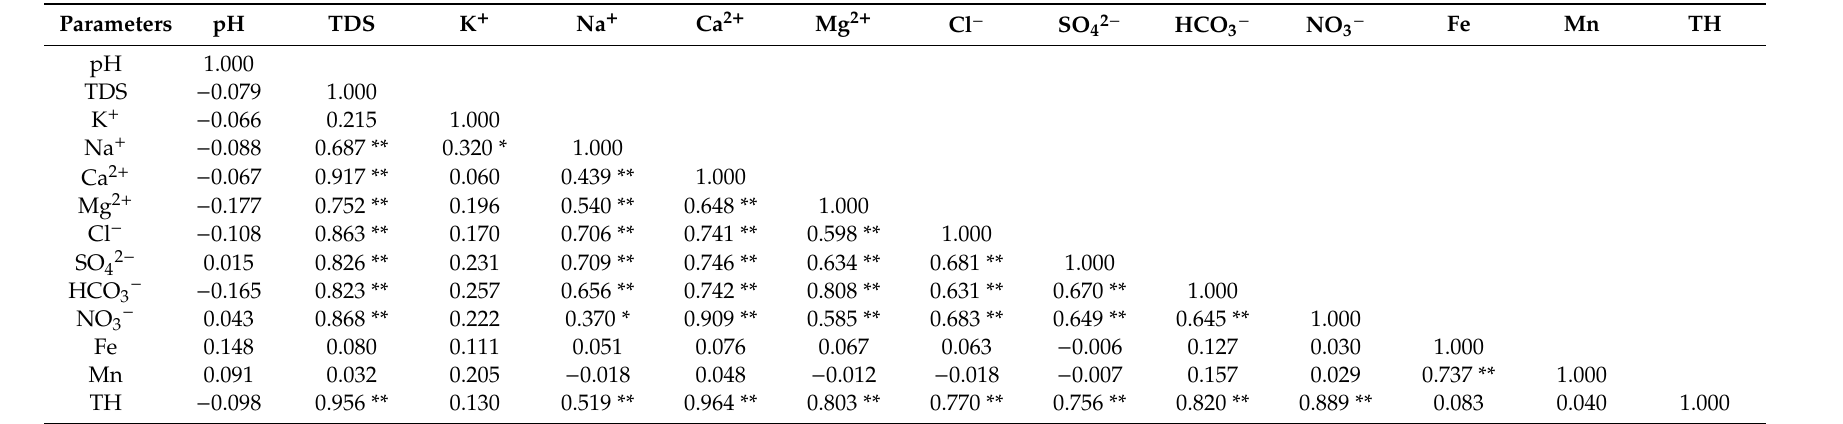
Table 2. Spearman’s correlation matrix of water quality of groundwater in the Hutuo River alluvial-pluvial